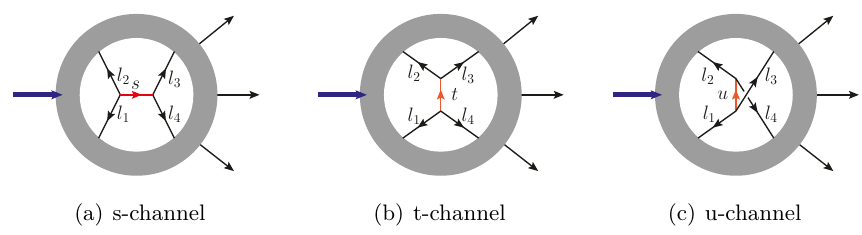
Figure 1. s, t, u -channel graphs related by Jacobi